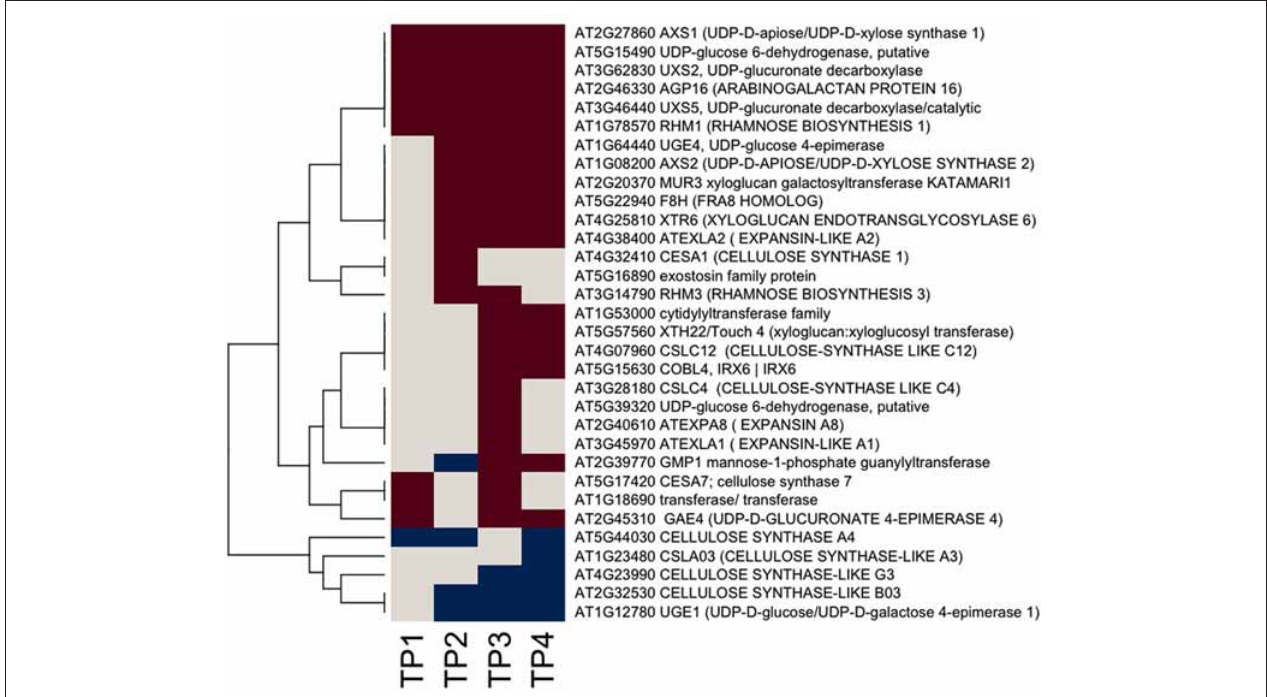
significant positive expression changes, blue cells represent significant negative changes, and off-white cells represents no change or no statistically significant change.